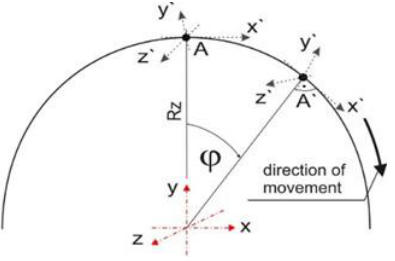
Figure 11. Scheme of the source movement in a cylindrical system [33].